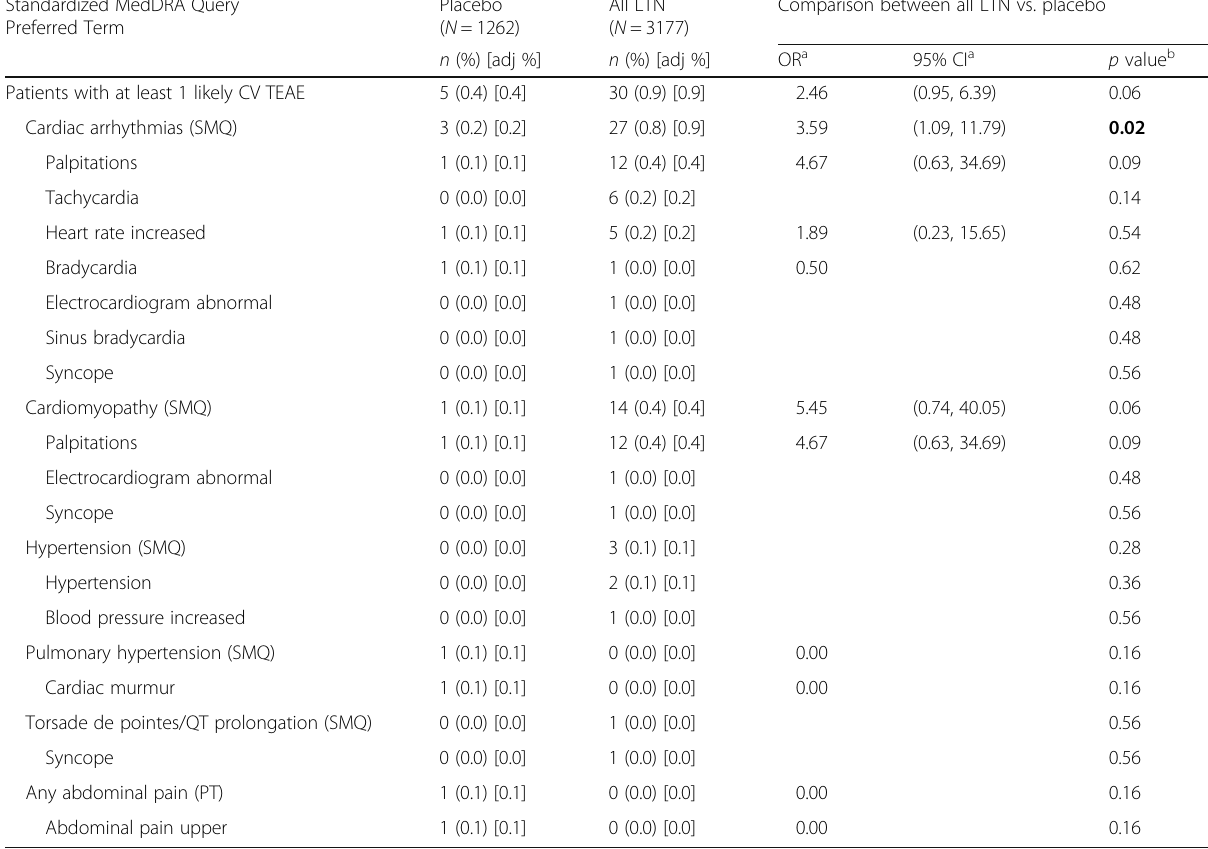
Placebo All LTN Comparison between all LTN vs. placebo ( N = 1262) ( N = 3177)